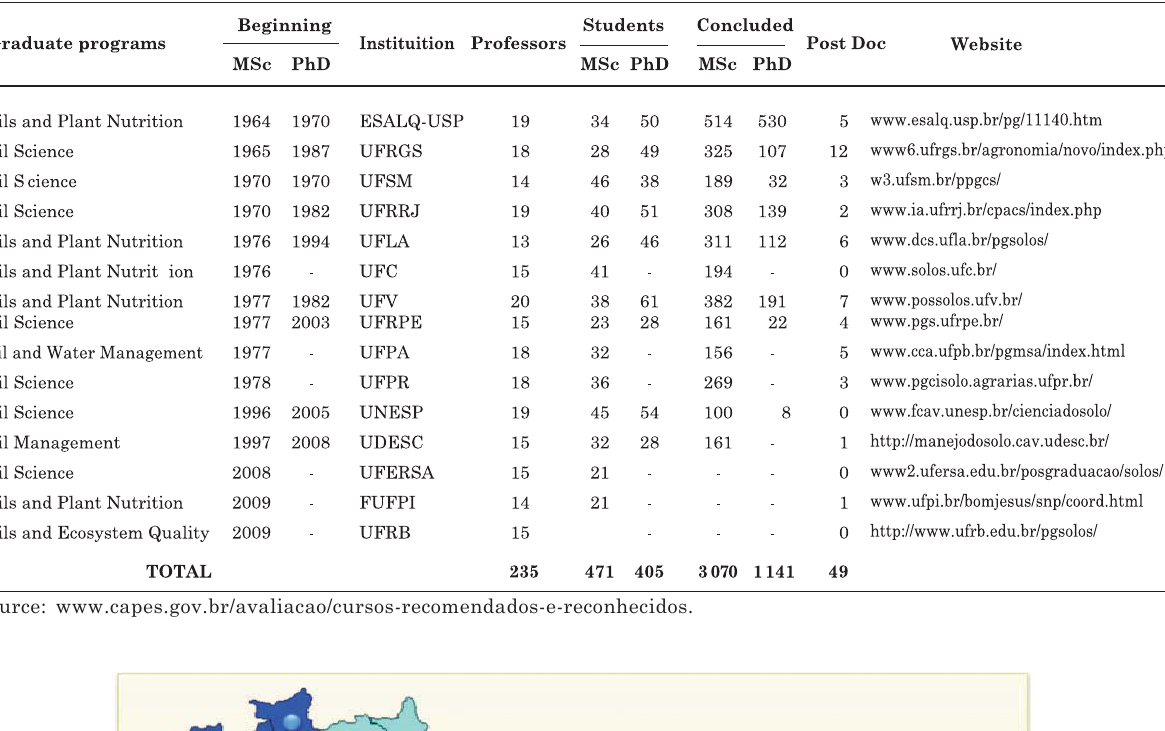
Table 3. Characteristics of graduate programs in Soil Science in